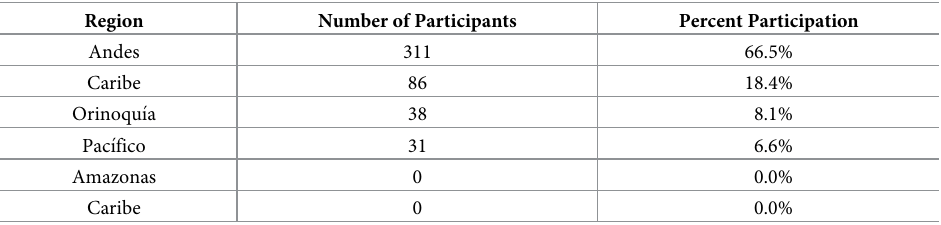
Table 1. Colombian regions with number and percent study